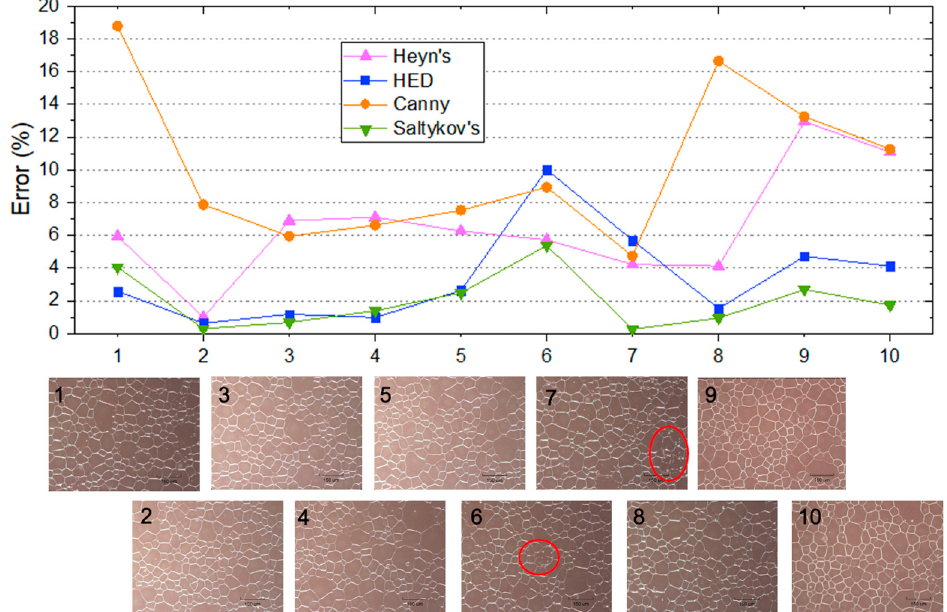
Figure 5. A comparison of four grain determination methods’ error to the average grain Haywood diameter (ground truth). For reference, the micrographs are located underneath, with areas of lower resolution circled in